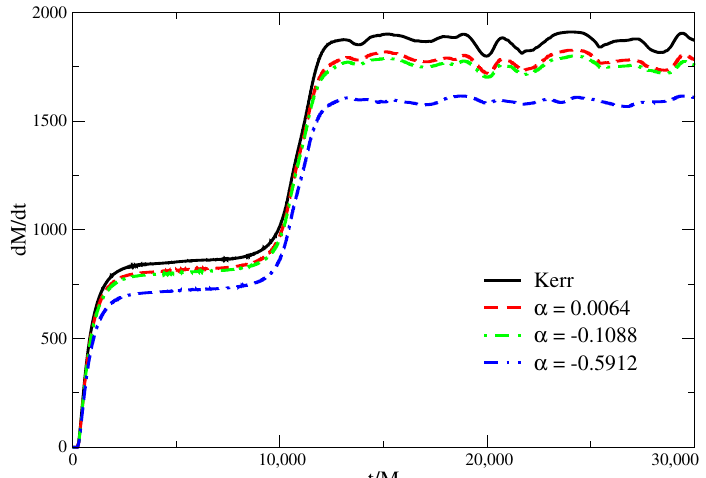
Figure 4. Mass-accretion rate for asymptotic velocity V ∞ = 0.1.